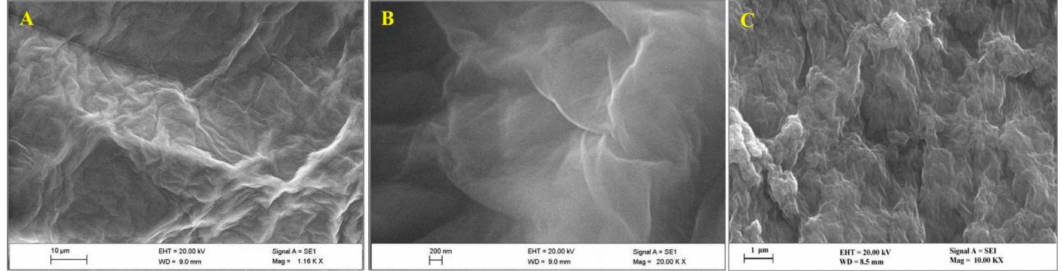
Figure 1. SEM pattern of GR ( A , B ) and PVP-GR composite ( C ). (Accelerating voltage: 20 kV, magnification times: